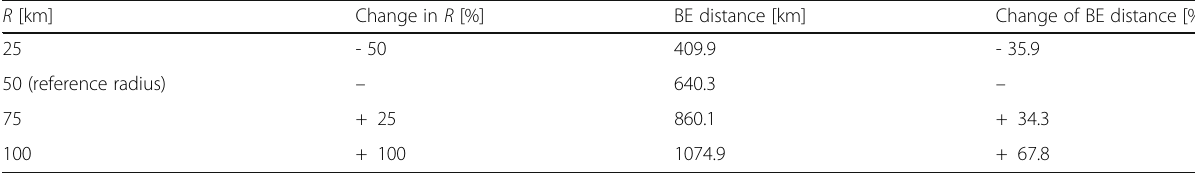
Table 4 Sensitivity analysis of the break-even distance with regard to the radius of the market area R [km] Change in R [%] BE distance